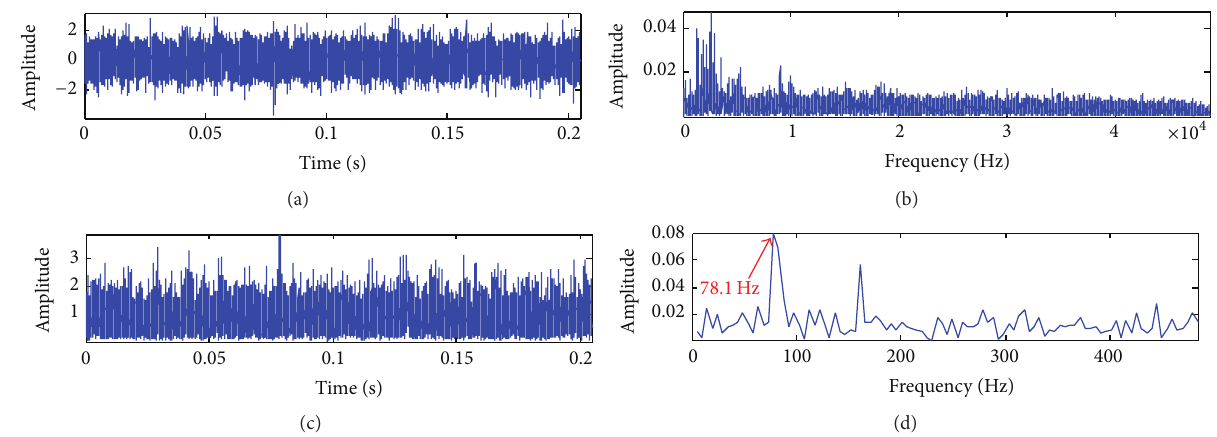
Figure 15: Experimental vibration signal with early stage defect: (a) time waveform; (b) power spectrum; (c) envelope waveform by Hilbert transform; (d) envelope